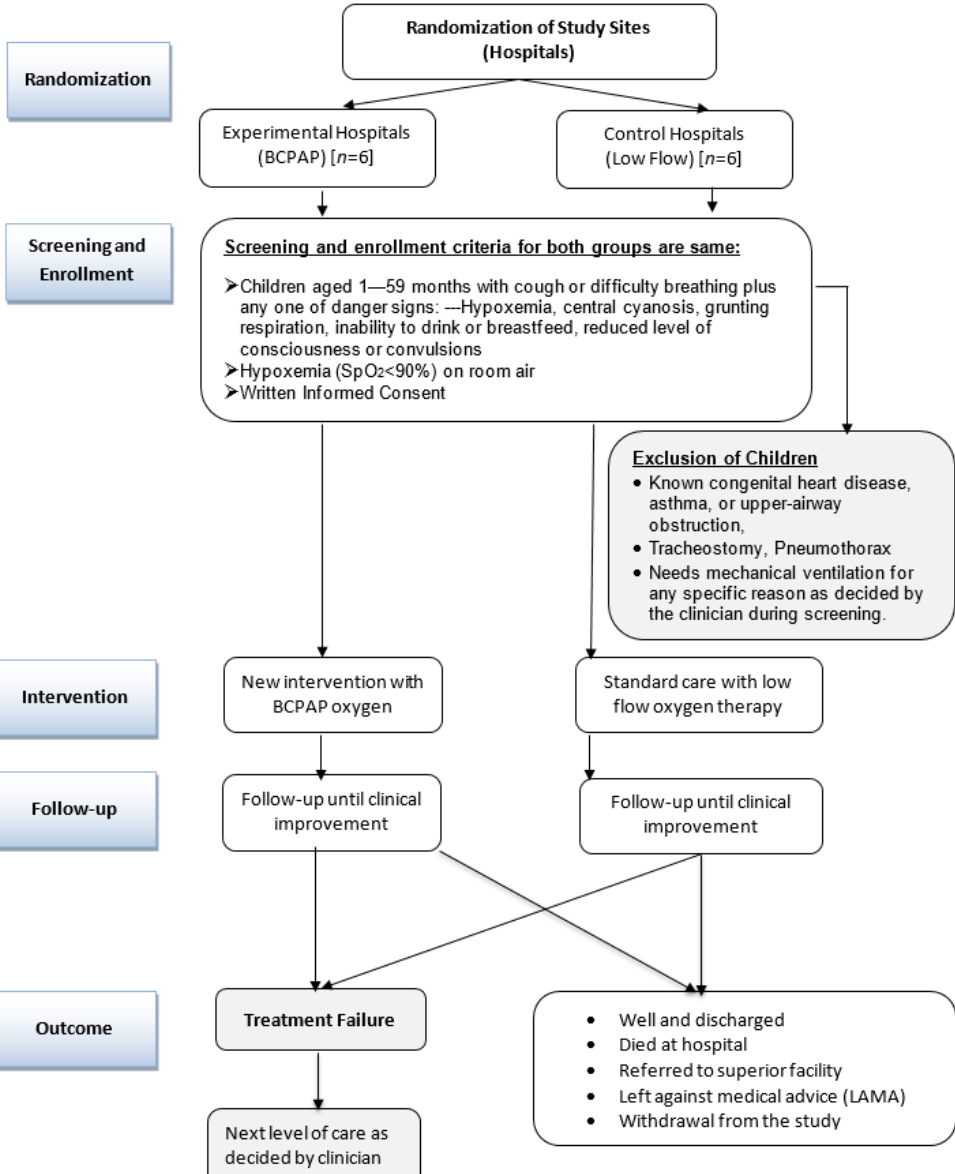
Figure 1. Flowchart for the pragmatic cluster randomized controlled trial.